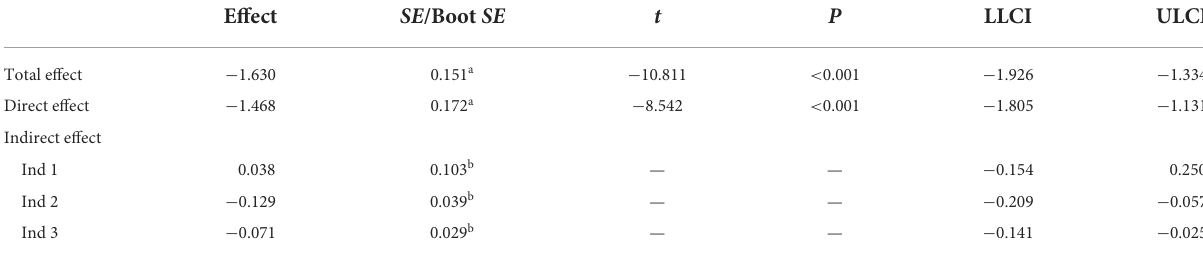
TABLE 3 The chain mediating effect of life satisfaction and social support between perceived stress and humanistic care ability.